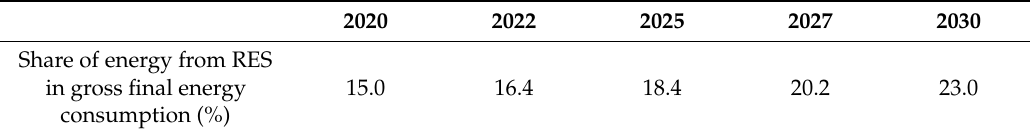
Table 10. Proposal of trajectory of renewable energy according to the National Energy and Climate Plan